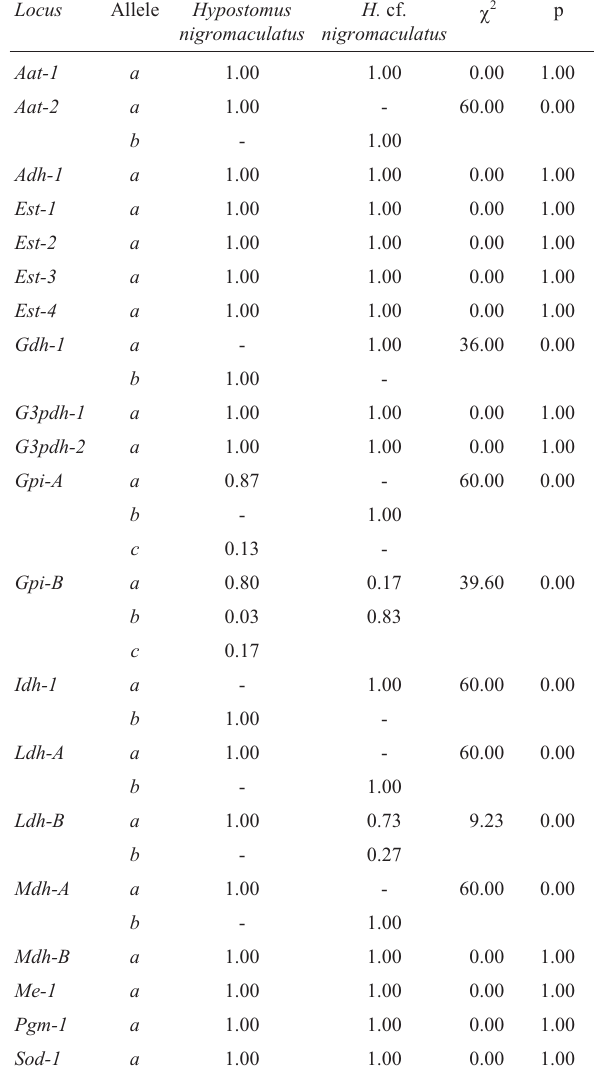
Table 2 - Allele frequency and the homogeneity chi square test ( (cid:4) 2 ) for each of the 20 loci detected by the corn gel electrophoresis technique in Hypostomus nigromaculatus and Hypostomus cf. nigromaculatus from the Atlântico Stream (Paraná State, Brazil) (p = chi square probability).